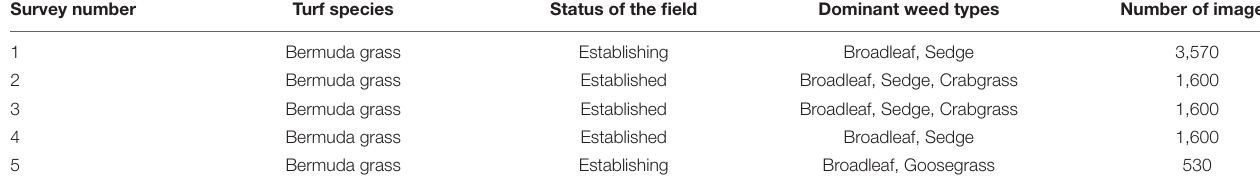
TABLE 1 | Summary of the training images from six surveys conducted on Georgia sod farms in 2019 and 2020. Survey number